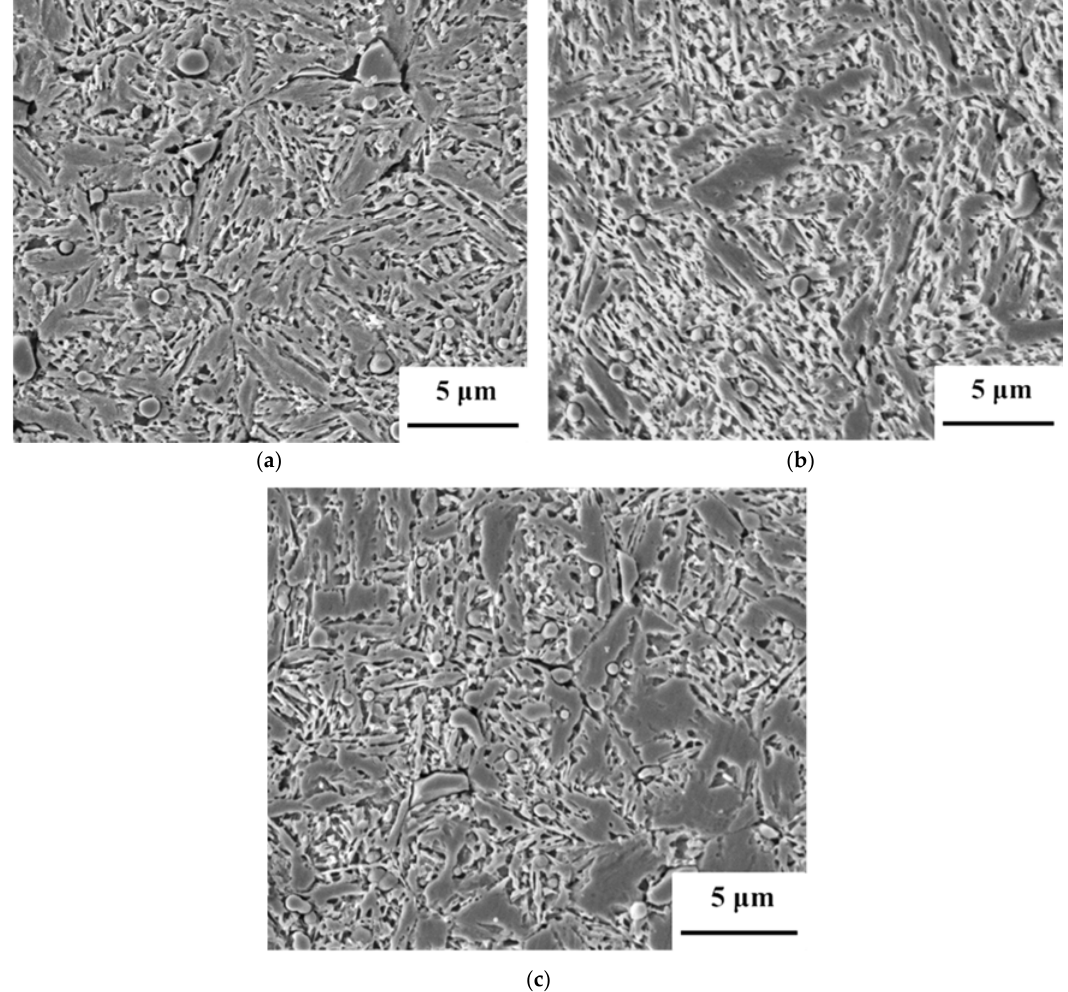
Figure 3. Microstructural characteristics of the austempered specimens (1080 °C ‐ 30 min) with a salt ‐ bath time of 120 min and different salt ‐ bath temperatures: ( a ) 200 °C, ( b ) 300 °C, and ( c ) 400 °C.